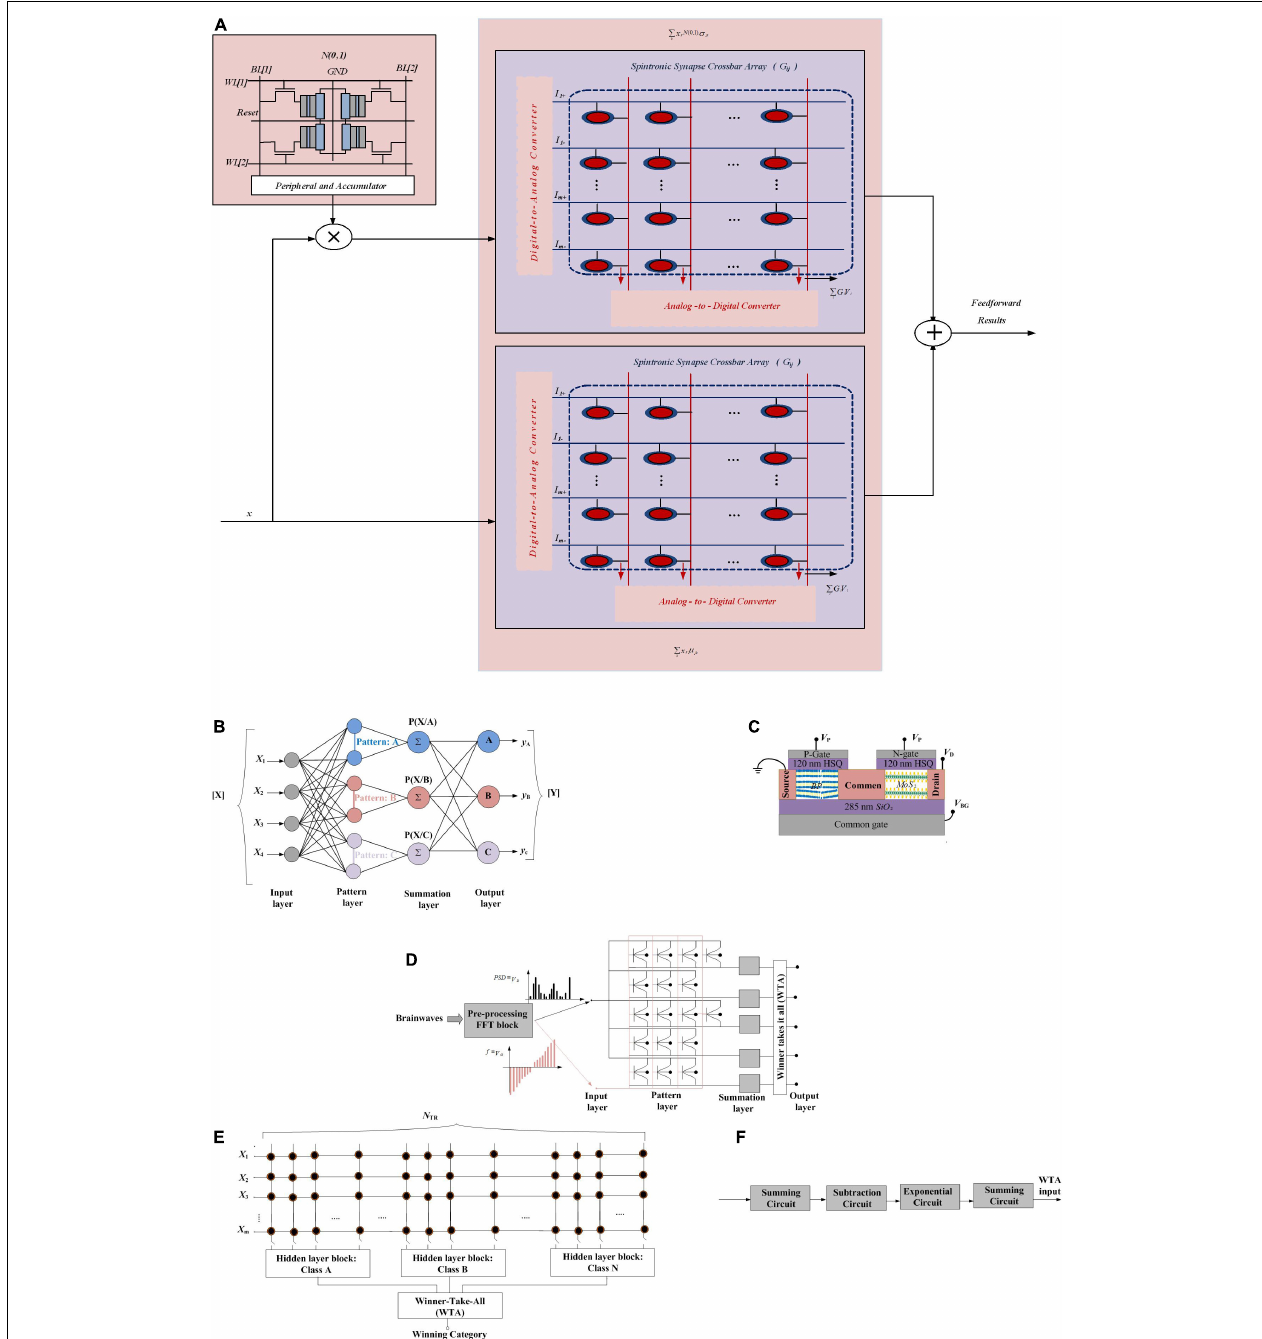
FIGURE 12 | (A) All-spin Bayesian neural network implementation. The RNG unit performs sampling operation from Gaussian random number generators and the two crossbar arrays provide the “In-Memory” computing kernels (Malhotra et al., 2020). (B) The structure of the Probabilistic Neural Network (PNN) model (Gaussian Synapse based PNN) translates any input pattern to any number of output classifications through using a pattern layer and a summation layer. (C) Schematic of a reconfigurable Gaussian synapse composed of dual-gated n-type MoS 2 and p-type black phosphorus (BP) back-gated field-effect transistors (FETs). Hydrogen silsesquioxane (HSQ) was used as the top-gate dielectric and nickel/gold (Ni/Au) was used as the top-gate electrode. (D) PNN Architecture for Brainwave recognition. The amplitude of the FFT data is passed from the input layer to the pattern layer as drain voltage ( V D ) of the Gaussian synapses, and the frequency range is mapped to the back-gate voltage ( V G ) range. The summation layer integrates the current over the full swing of V G from the individual pattern blocks and communicates with the winner-takes-it-all (WTA) circuit and then the output layer recognizes the brainwave patterns. (E) The architecture of the PNN (Akhmetov and Pappachen, 2019) is implemented with crossbar arrays where each class has been implemented with a crossbar array where N TR denotes the total size of the training set (classes). (F) Block diagram of the hidden layer block.